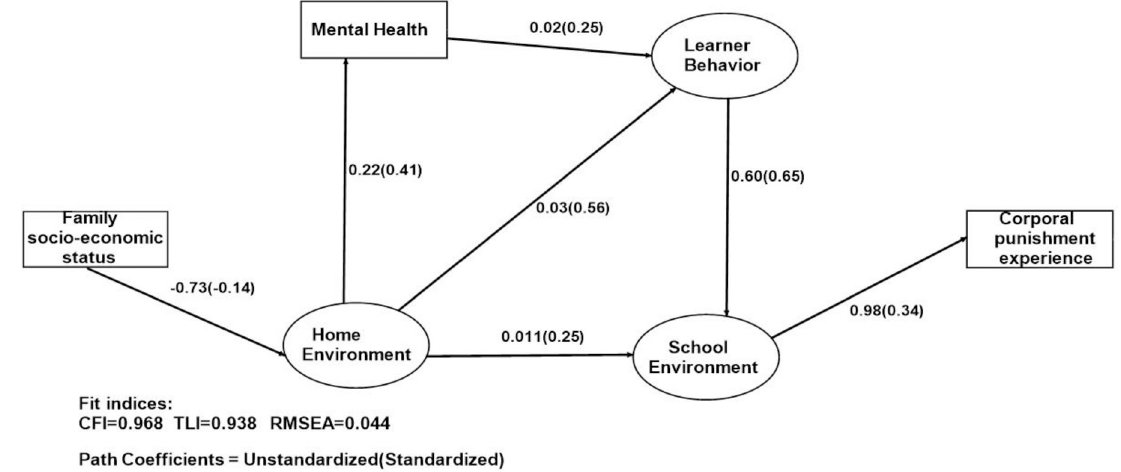
Fig 3. Pathways to experiencing corporal punishment at school among